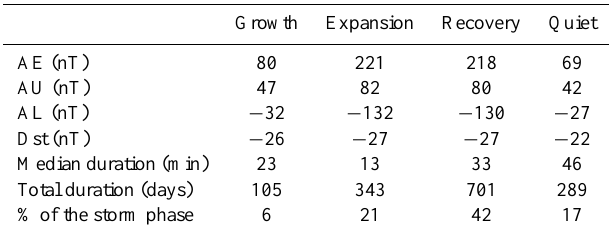
Table 5. Median values of substorm phases during storm recovery